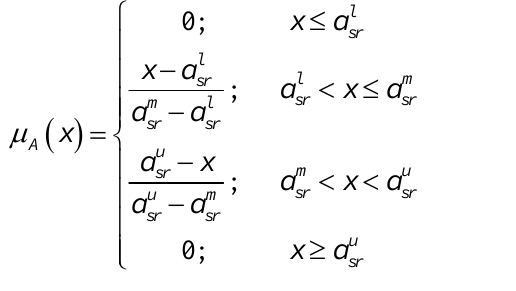
Table 1 – The expert assessment of the nature of the strategic factors influencing the forest road network